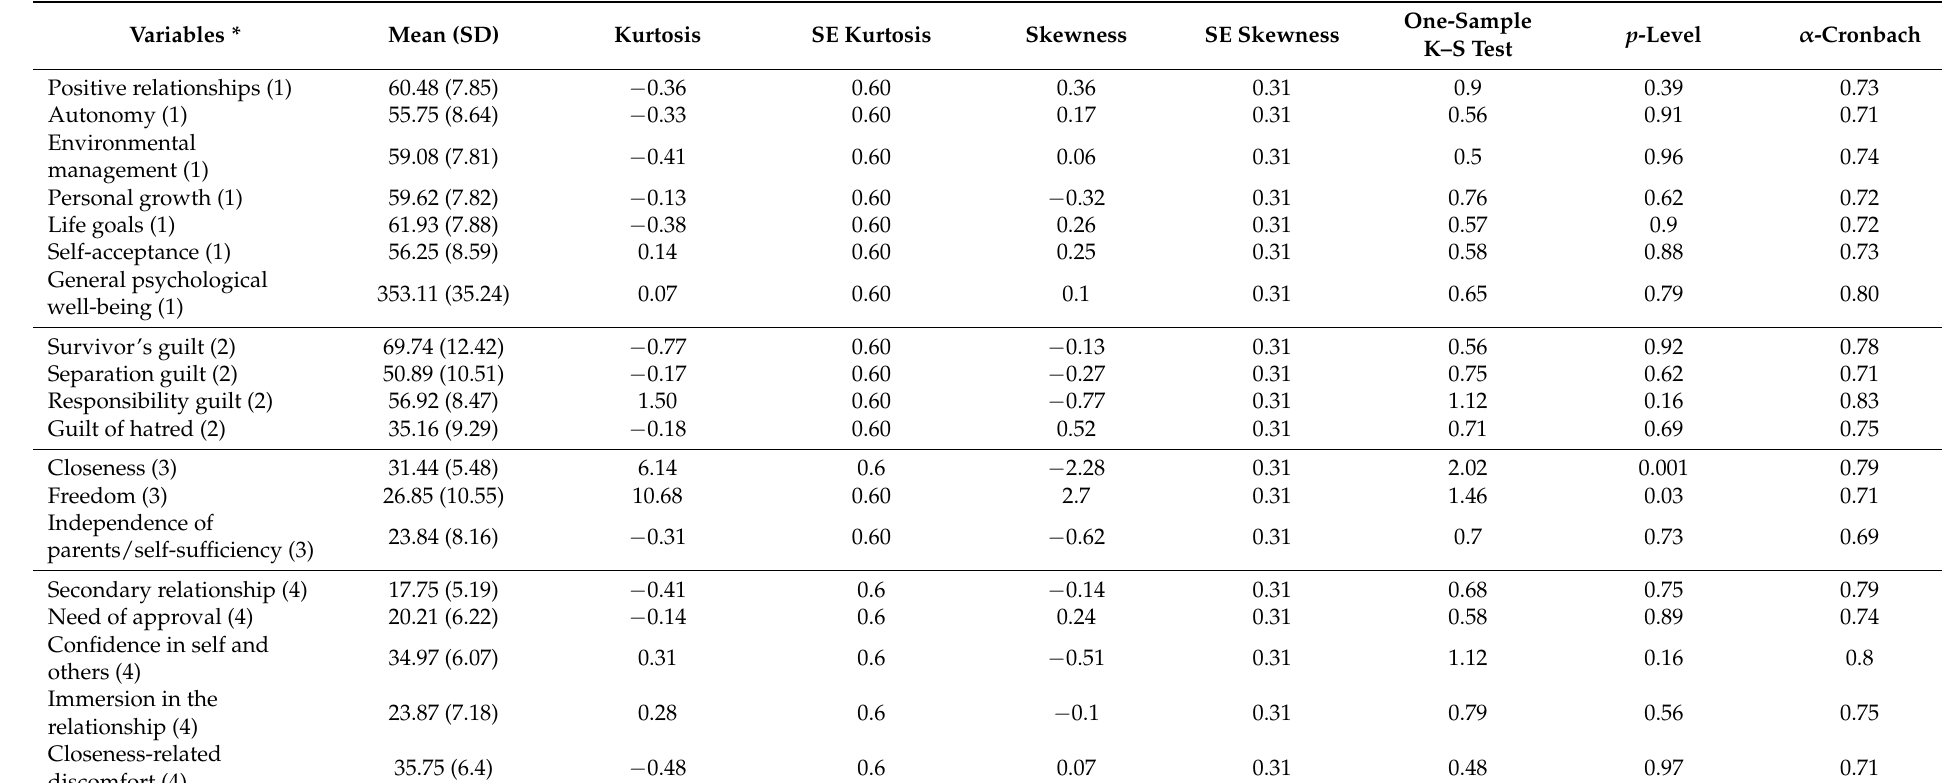
Table A3. Basic descriptive statistics for the variables included in Study 1 ( n =